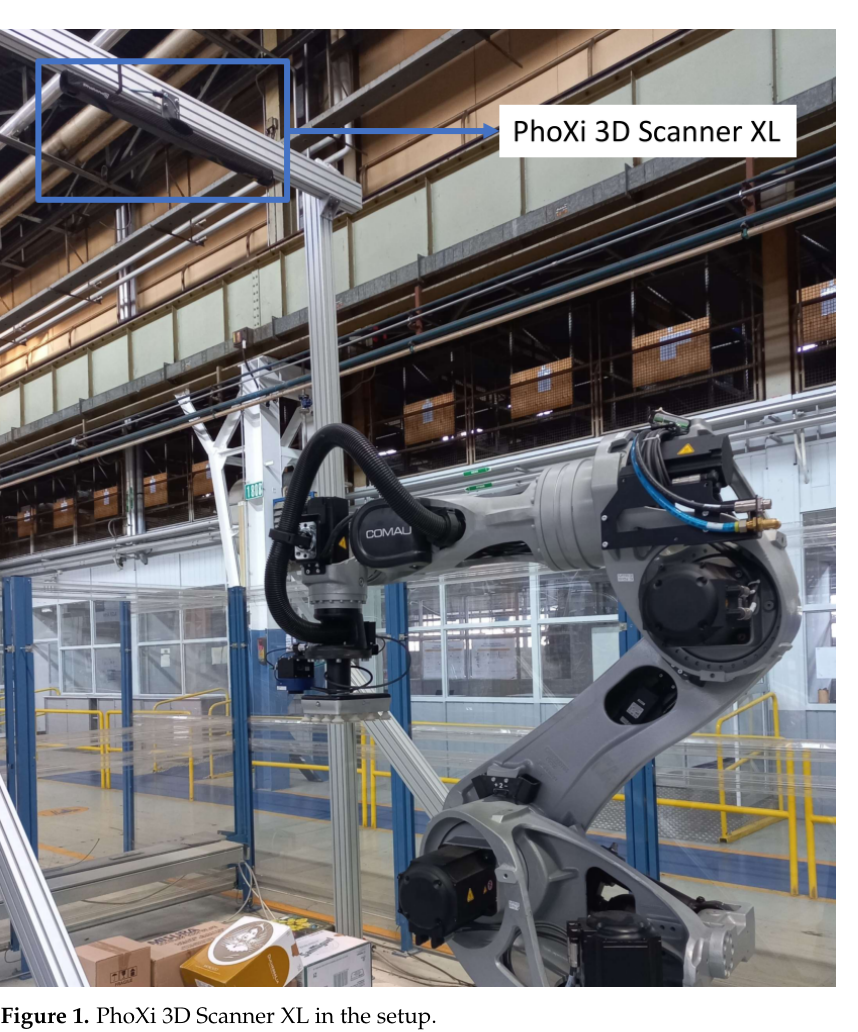
Figure 1. PhoXi 3D Scanner XL in the setup.